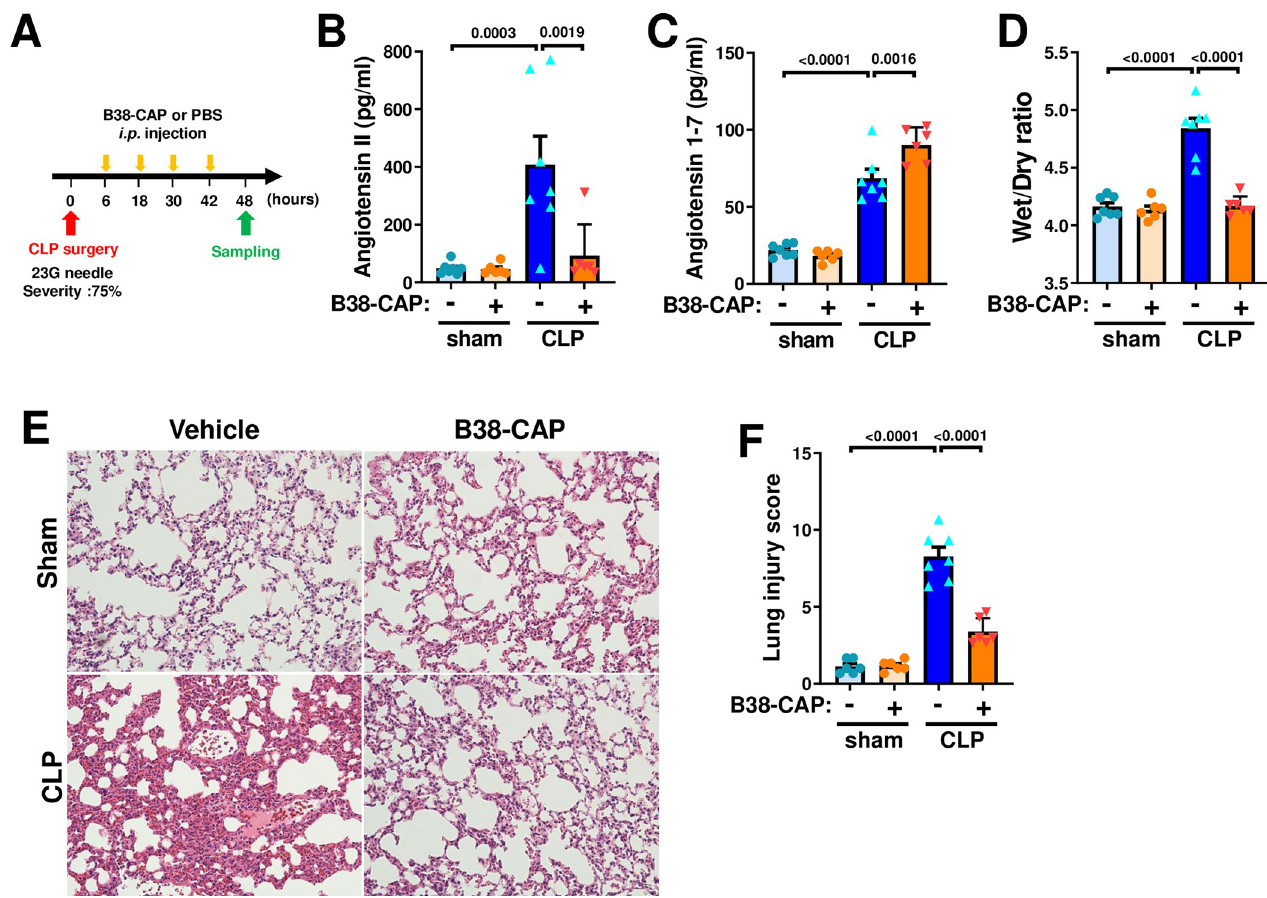
Fig 3. Effects of B38-CAP on lung injury induced by CLP in mice. A , Experimental protocol. The mice with CLP were treated with B38-CAP (2 mg kg − 1 per day) or vehicle, and samples were harvested at 48 hours after CLP surgery. sham + vehicle (n = 7), sham + B38- CAP (n = 6), CLP + vehicle (n = 7) and CLP + B38-CAP (n = 6). B , Measurements of plasma Ang II in the mice. C, Ang 1–7 levels in the plasma. D, Wet to dry weight ratio for lung edema. E-F , Lung histopathology. Representative images are shown ( E ). Bars indicate 100 μ m. Lung injury score measurements ( F ). All values are means ± SEM. One-way ANOVA with Sidak’s multiple-comparisons test. Numbers above square brackets show significant